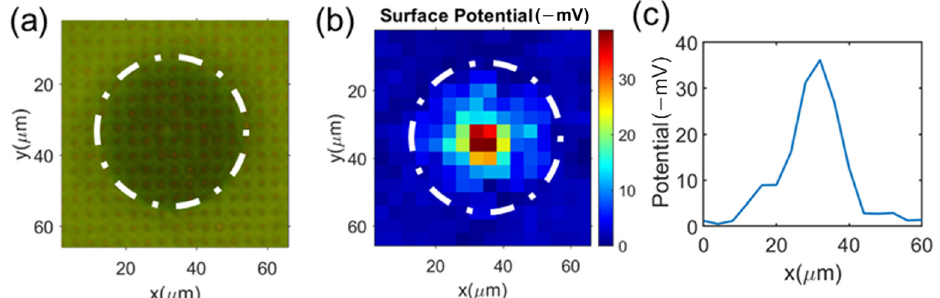
Figure 4. ( a ) Optical image (top illumination) of an MP sitting on the microelectrode array surface; ( b ) surface charge mapping measurement of this single MP using the microelectrode array; and ( c ) the profile of the measured surface electrical potential along the center line in the x-direction.